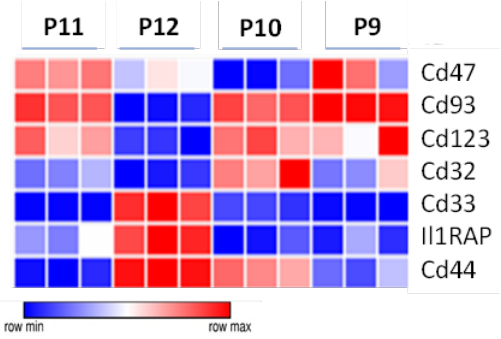
Figure 7. Specific drug-targeted genes expressed in ML23 cells. Differential expression levels of current treatment targets that are under study or clinical application were examined in the RNA-seq results of ML23 cells. Two of them (CD47 and CD93) presented overexpression on ML23 LIC (P11).